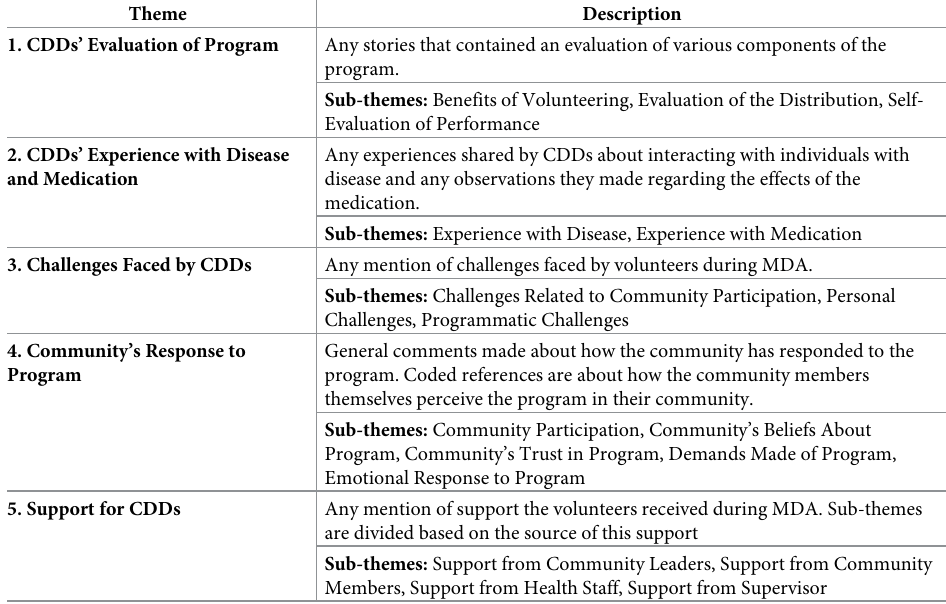
Table 5. Resultant themes and sub-themes from thematic analysis of micronarrative